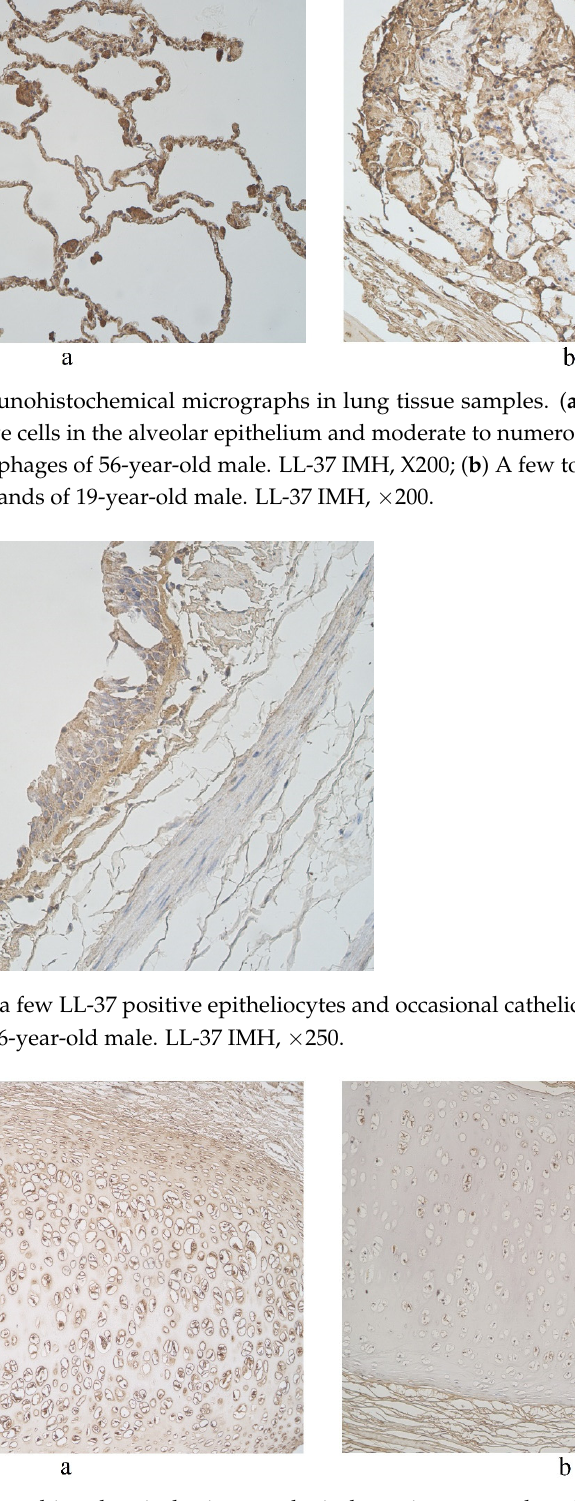
Figure 9. Immunohistochemical micrographs in lung tissue samples. ( a ) Note numerous LL-37 immunoreactive cells in cartilage of 19-year-old male. LL-37 IMH, X100; ( b ) A few LL-37 positive structures in cartilage of 19-year-old male. LL-37 IMH, ×100. A statistically significant difference was found between HBD-4 and HBD-2 ( p = 0.008) (Figure 10a), HBD-3 and HBD-2 ( p = 0.006) (Figure 10b), HBD-3 and IL-17A ( p = 0.005) (Figure 10c), HBD-4 and IL-17A ( p = 0.004) (Figure 10d), IL-17A and LL-37 ( p = 0.002) (Fig- ure 10e) in cartilage. Furthermore, a statistical significance in bronchial epithelium was found between HBD-4 and HBD-3 ( p = 0.038) (Figure 11a), HBD-2 and LL-37 ( p = 0.014) (Figure 11b), HBD-2 and IL-17A ( p = 0.009) (Figure 11c), HBD-4 and LL-37 ( p = 0.009) (Fig- ure 11d), HBD-4 and IL-17A ( p = 0.006) (Figure 11e).